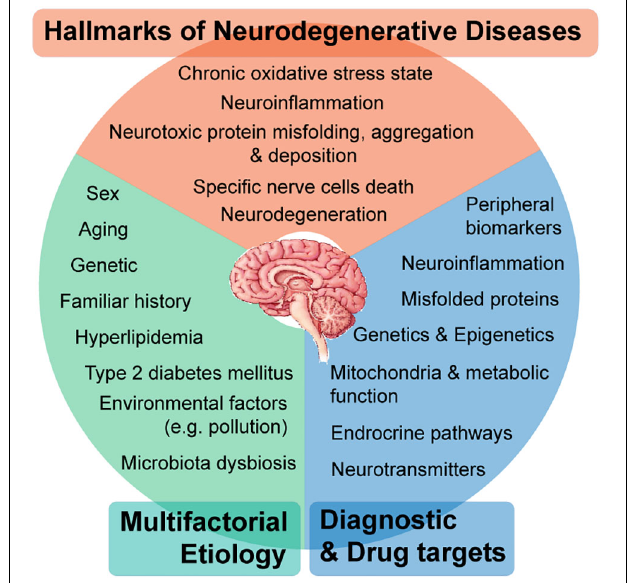
FIGURE 1 | Neurodegenerative diseases (NDDs) are a broad range of complex neurological disorders, however, presenting shared hallmarks. The pathophysiology of NDDs comprises multifactorial etiologies, where genetic, environmental, and behavioral factors contribute with causal roles. Even though being distinctly manifested (e.g., compromised cognition in Alzheimer’s disease or motor functions in Parkinson’s disease), at the molecular level, there are many shared perturbed mechanisms comprising hallmarks of NDDs, which in turn leads to several potential target approaches for earlier diagnosis and effective therapeutics from a personalized medicine